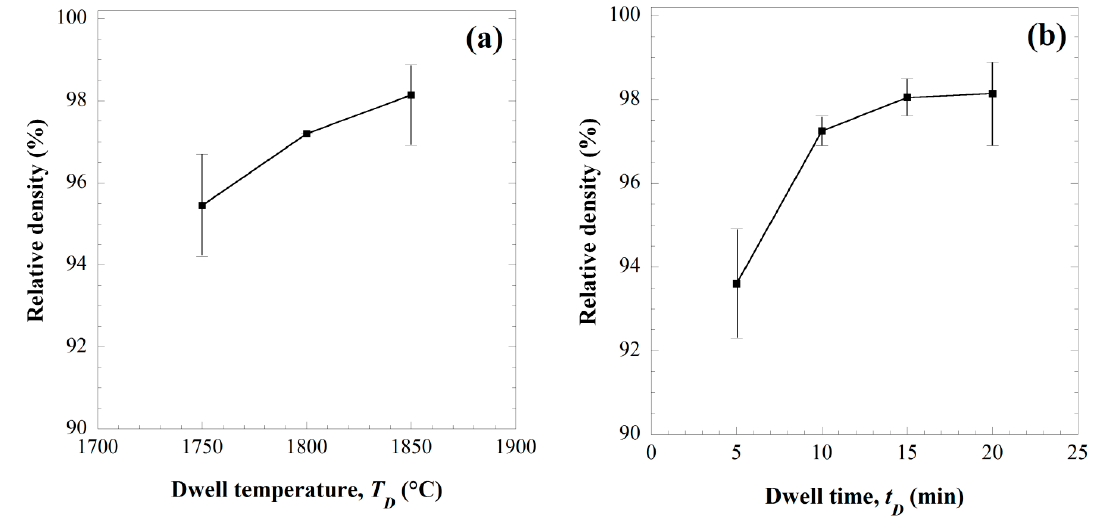
Figure 4. Effect of ( a ) the sintering temperature ( t D = 20 min, p = 50 MPa, t H = 10 min) and ( b ) dwell time ( T D = 1850 °C, p = 50 MPa, t H = 10 min) on the density of ZrC samples obtained by SPS.